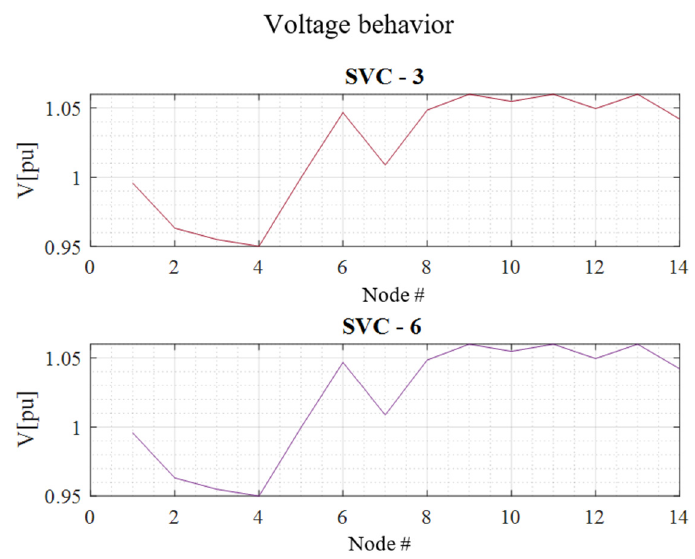
Figure 6. Voltage profile in the IEEE 14-node system: SVC 3 and 6.